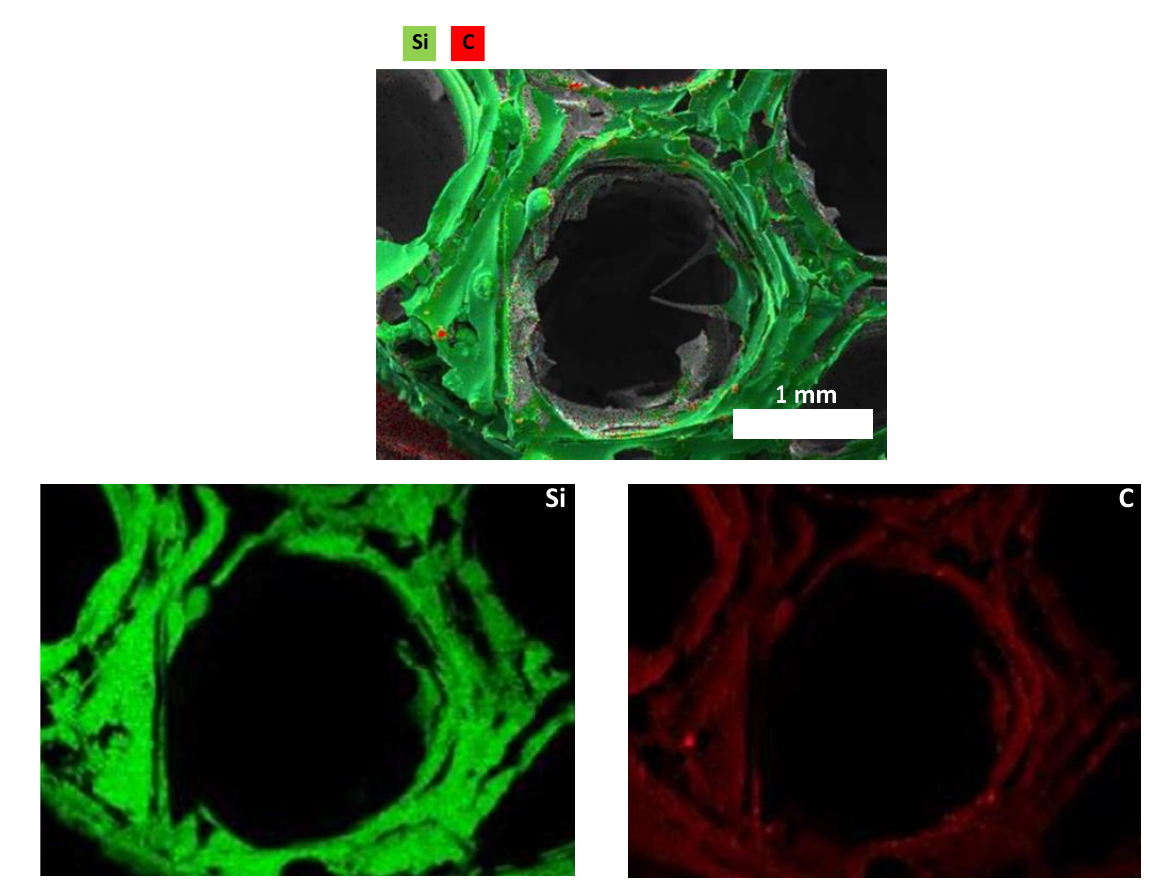
Figure 5. Elemental mapping of 3D SiC. Table 2. Elemental composition of the 3D ceramics (wt%).